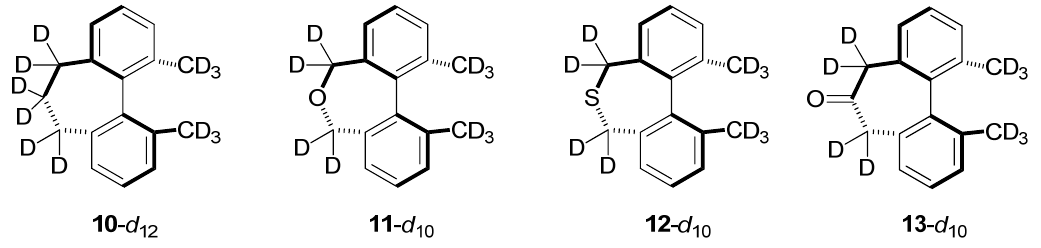
Figure 7. Analogs for in silico comparison with Mislow’s dihydrodimethylphenanthrene.